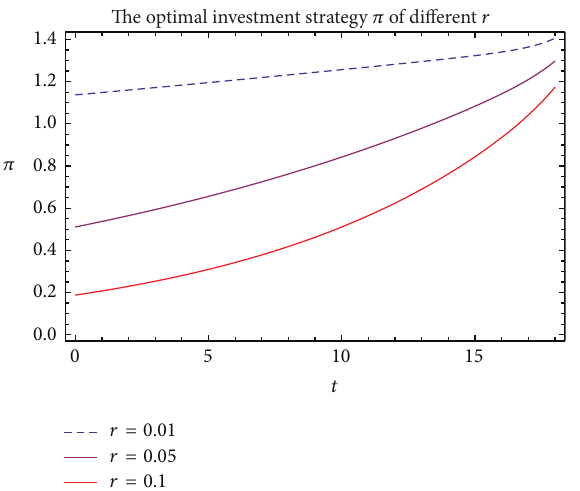
Figure 4: Evolutions of optimal investment strategy 𝜋 ∗ with different correlation coefficients 𝜌